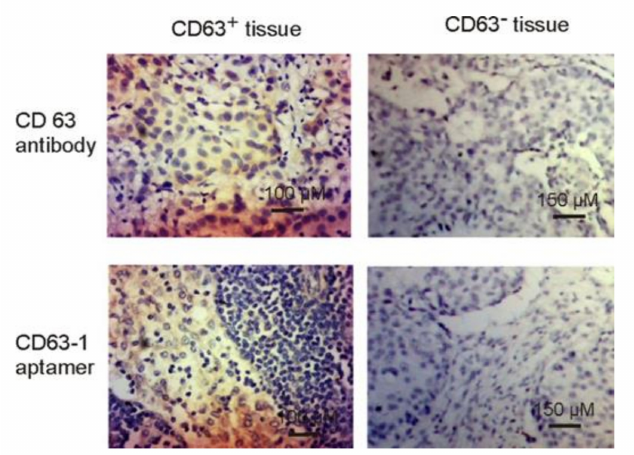
Figure 5. Immunostaining assay of CD63-positive and negative breast cancer tissue. Both CD63 aptamer and CD63 antibody were used. H&E stain was conducted for morphological